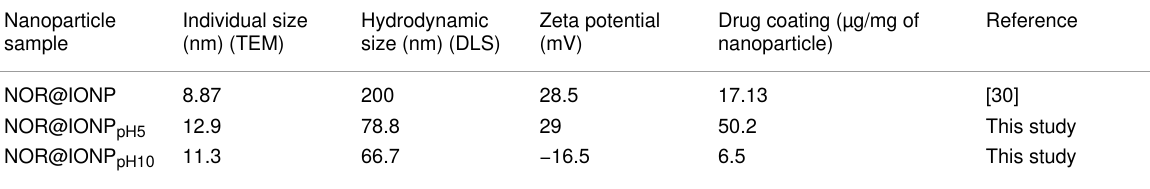
Table 2: Comparison of different NOR@IONPs synthesized in previous and current studies. Nanoparticle